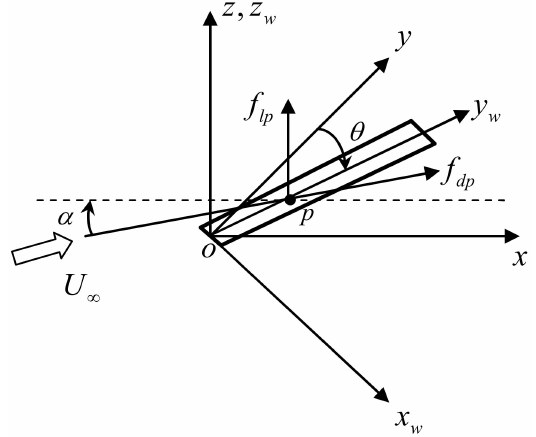
Figure 3. Aerodynamic forces equivalent to the node p